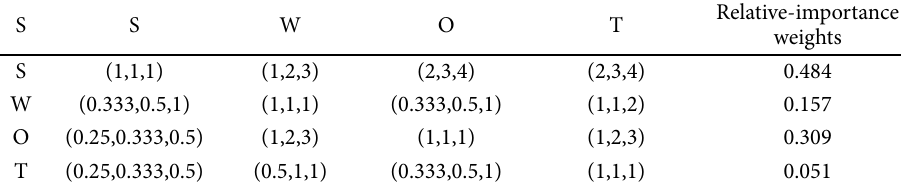
Table 3. The relative-importance weights for the “S”